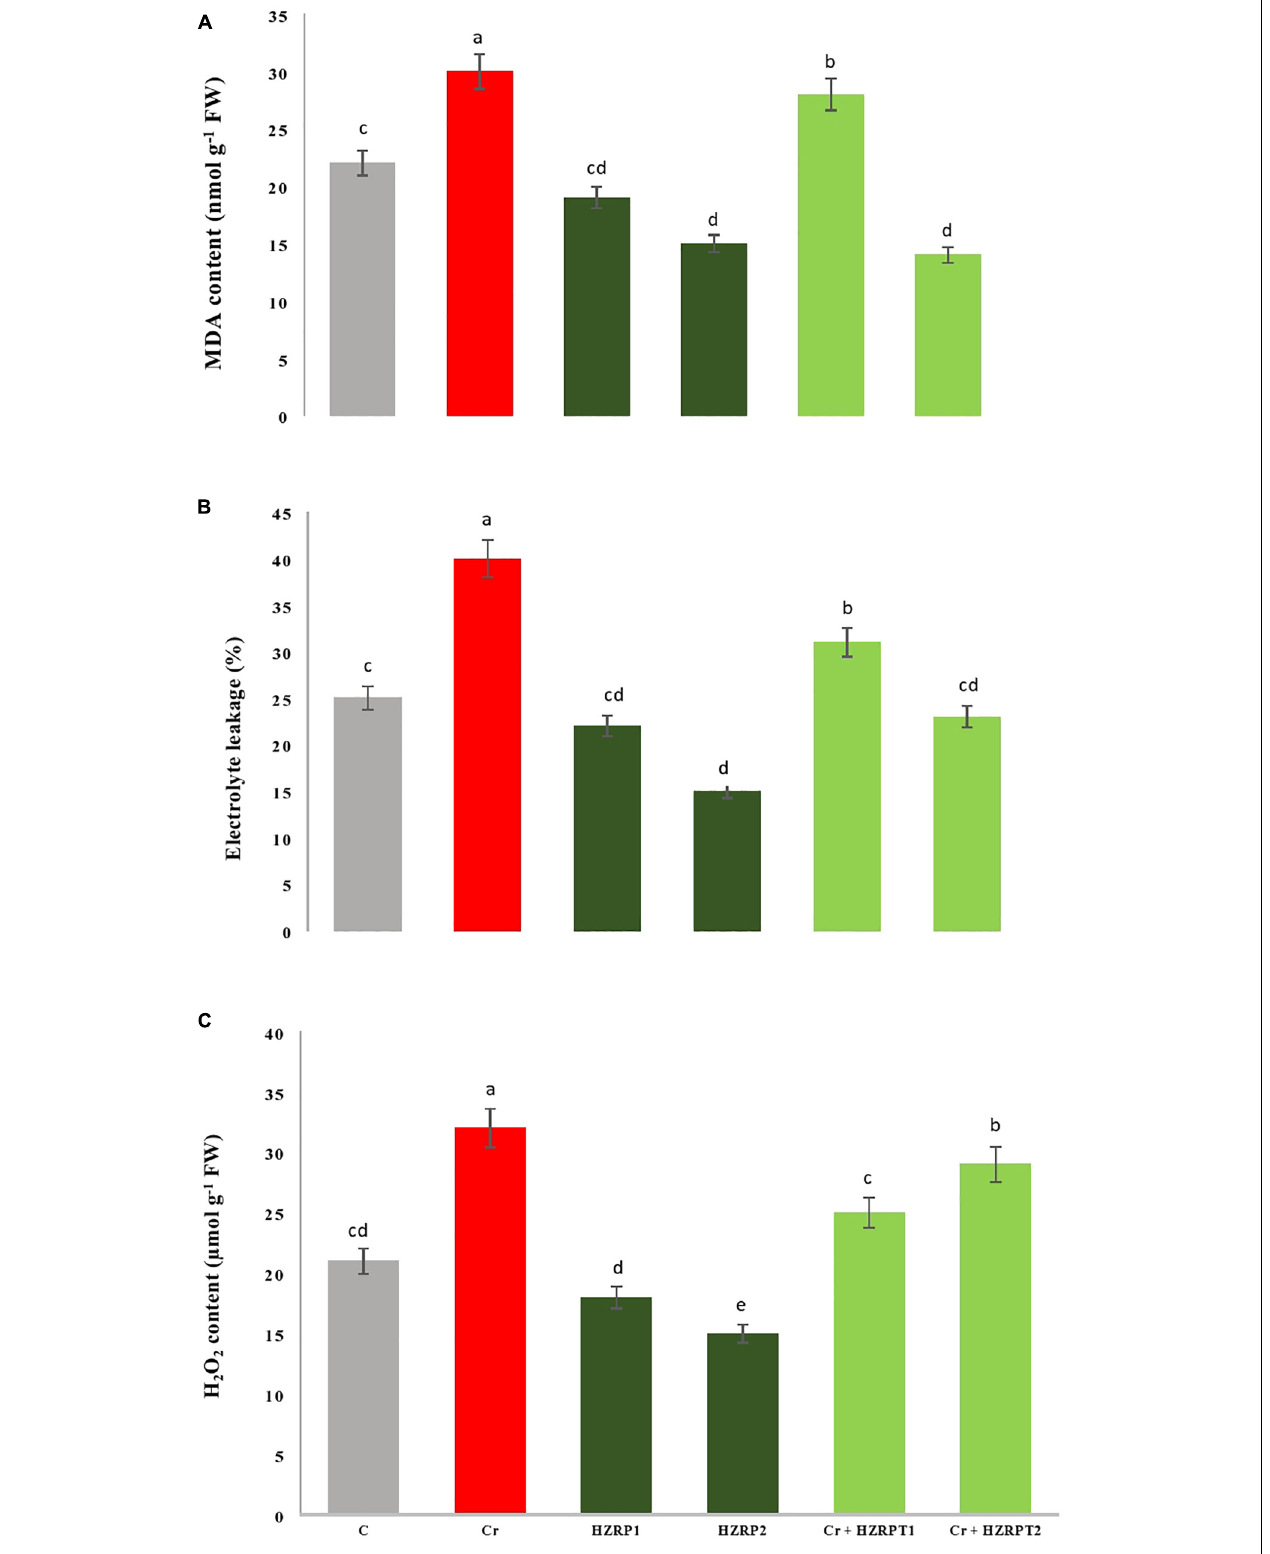
FIGURE 2 | Effect of HZRP on malondialdehyde content (A) , electrolyte leakage (B) and hydrogen peroxide content (C) in V. radiata seedlings grown in Cr toxificaled soil. Different letters indicate significant difference among the treatments ( p < 0.05). Cr, 50 mg kg − 1 , HZRP1, 1 p.p.m; HZRP2, 2 p.p.m.